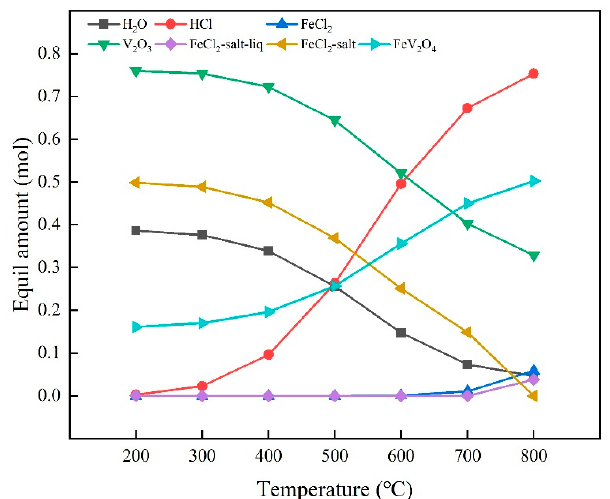
Figure 4. Changes in the content of each substance in the reaction of FeV 2 O 4 with HCl with increas- ing temperature .